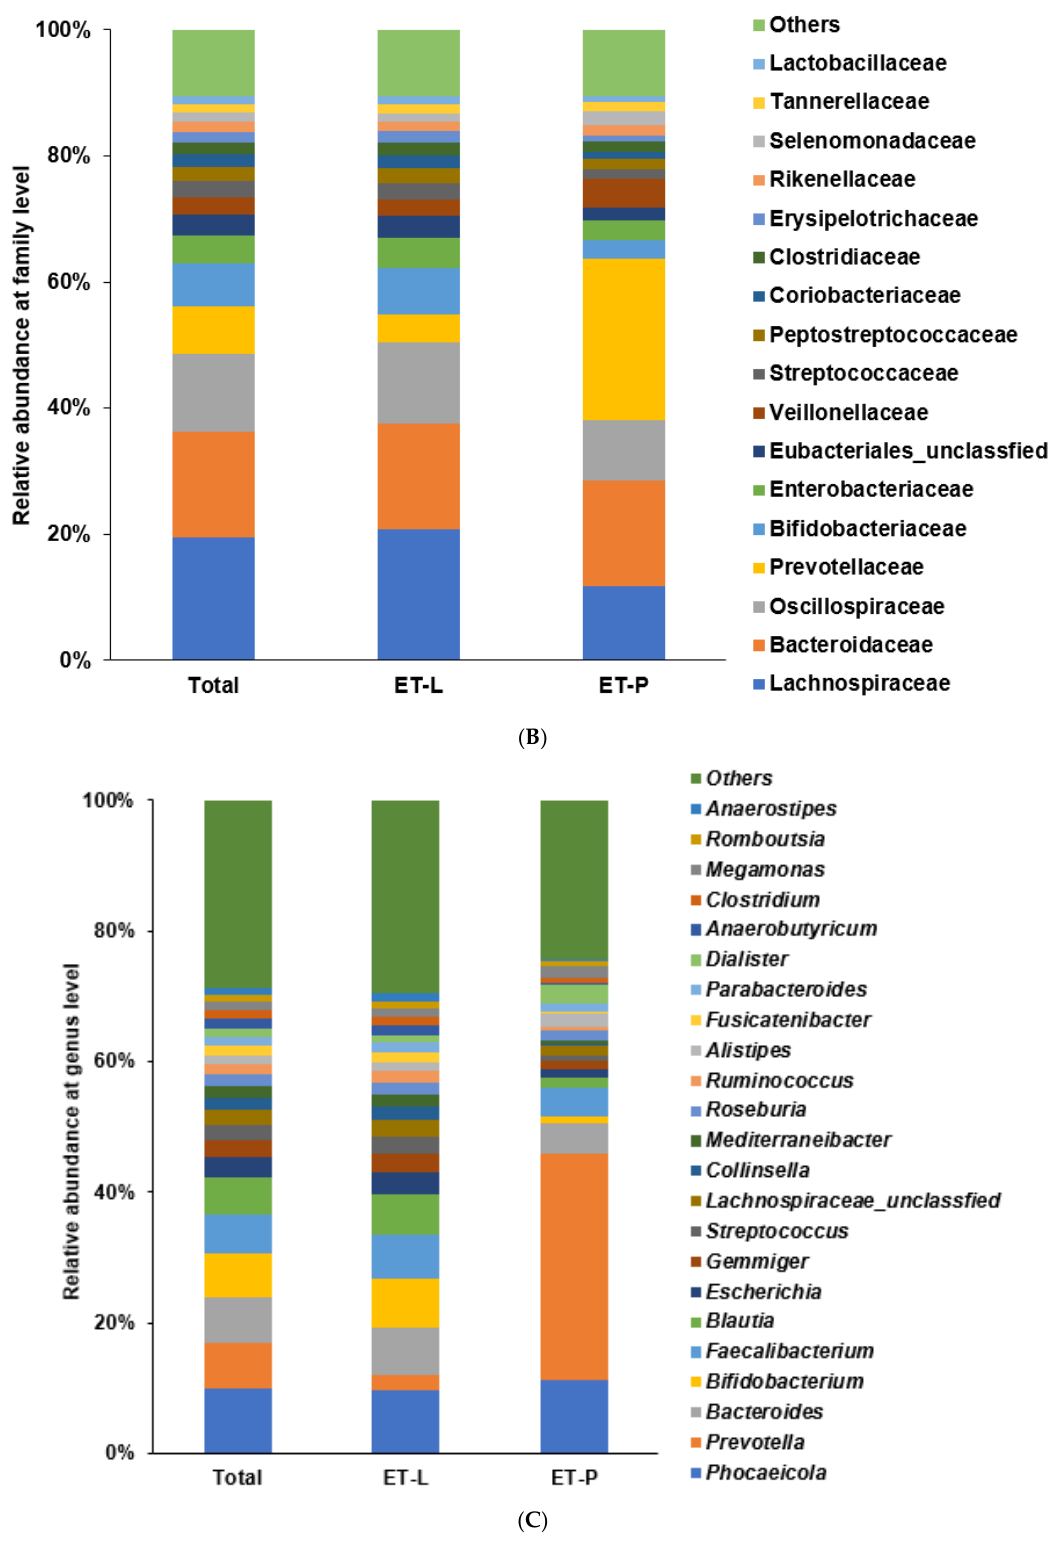
Figure 2. Fecal bacteria stratification into two enterotypes and bacterial composition in each en- terotype. ( A ) Fecal bacteria clustering (two enterotypes). Red and blue colors indicated ET-L and ET-P communities, respectively; ( B ) Relative abundance of fecal bacteria in each enterotype at the family level; ( C ) Relative abundance of fecal bacteria in each enterotype at the genus level; ET-L: Enterotype Lachnospiraceae; ET-P: Enterotype